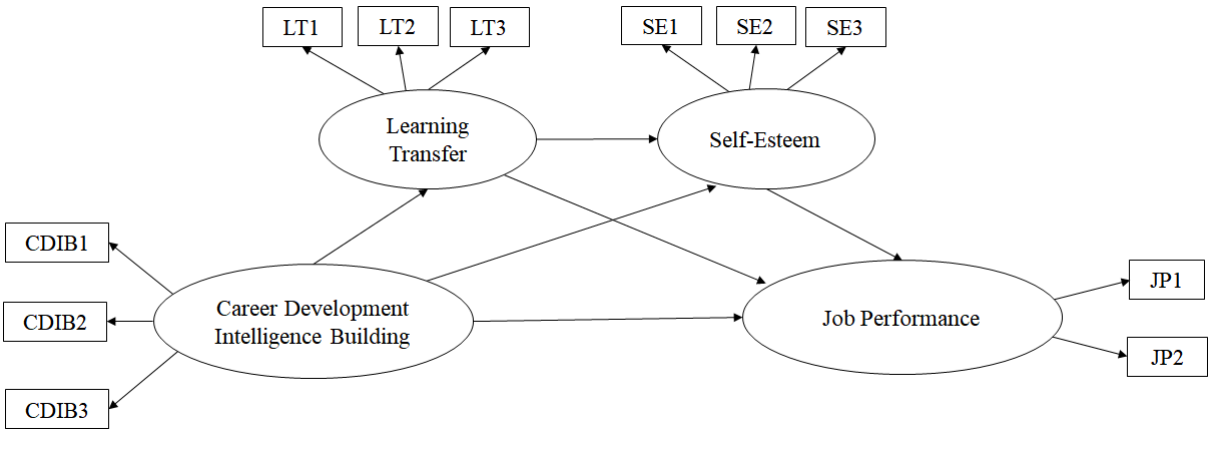
Figure 2. Partial mediation model.